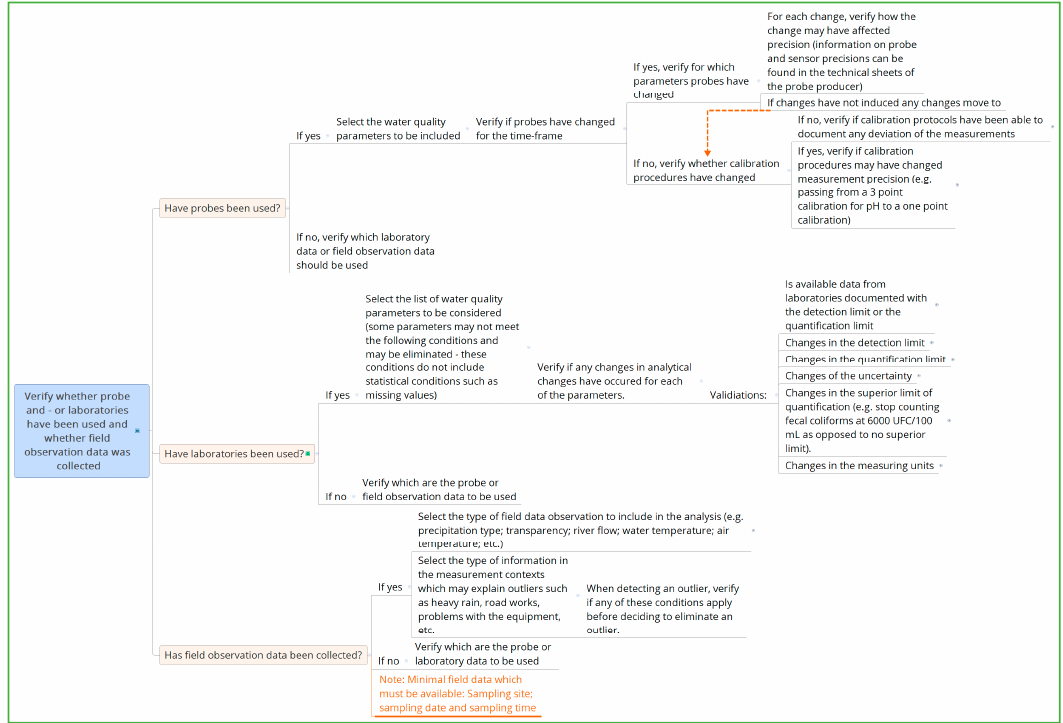
Figure 8. Extraction of the decision-support questions on available data series to validate (and understand) integrity, comparability, and outliers.